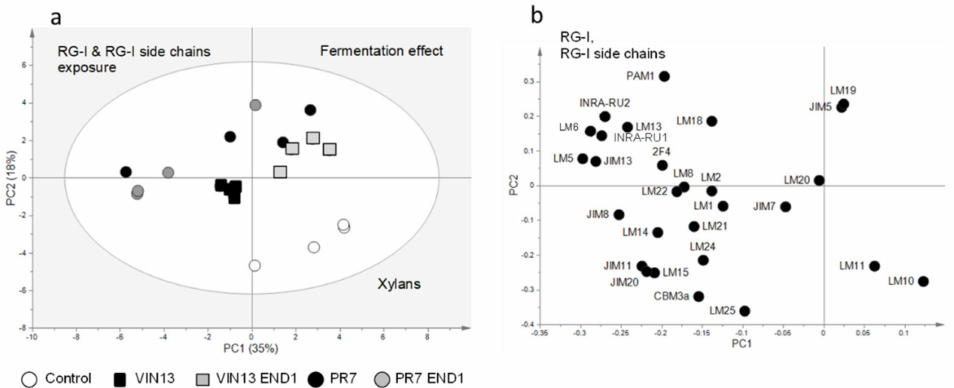
Figure 6. CoMPP data of the NaOH fraction portrayed in a PCA score ( a ) and loading plot ( b ) showing the impact of the hydrolytic enzymes (secreted by the yeast strains during the fer- mentation) on the pomace cell wall composition. Variable BS-400-2 was excluded from the